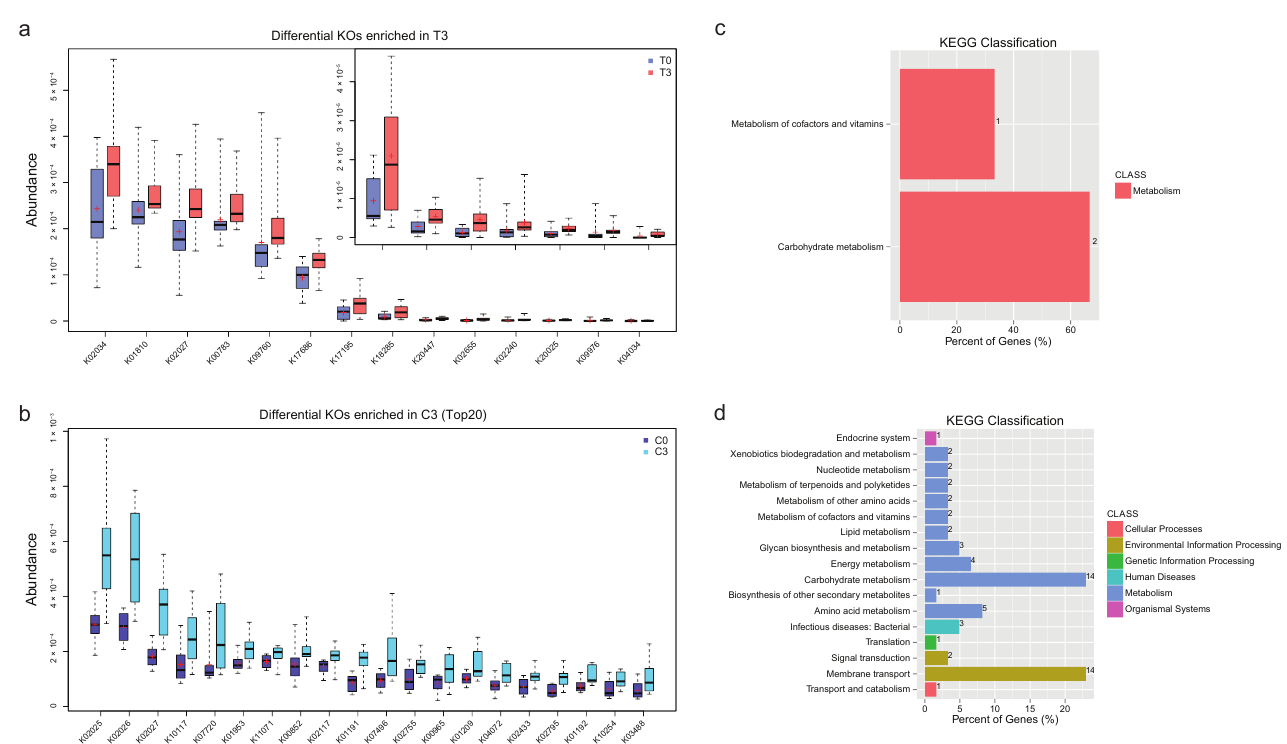
Figure 3. Functional analysis of differential KOs and the enrichment of the KEGG pathway. ( a ). The differential KOs were identified with the Wilcoxon rank-sum test ( p < 0.05) between T0 and T3 groups. ( b ) Significantly differential KOs ( p < 0.05) in the control group. ( c ) The KEGG classification of the differential KOs in the test group with the Level 1 and Level 2 information; ( d ). The KEGG classification of the differential KOs in the control